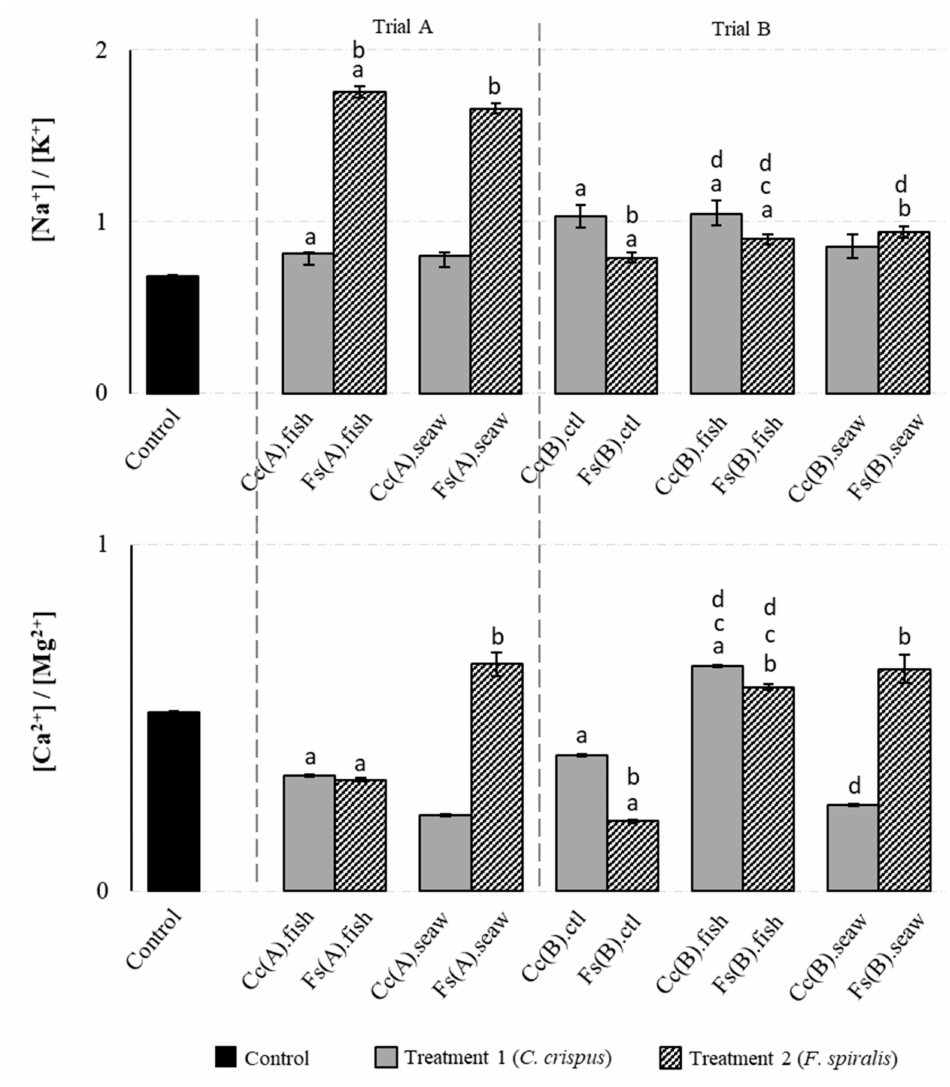
Figure 3. [Na + ] / [K + ] and [Ca 2 + ] / [Mg 2 + ] ratios of canned mackerel produced under the